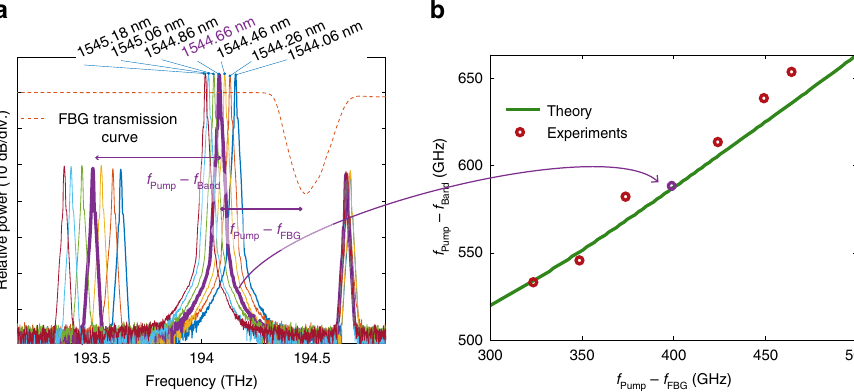
193.5 Fig. 3 Comb tuneability. a Output spectra for different pump wavelengths (from 1544.06 to 1545.18 nm). b Measured repetition rate as a function of the pump to fi bre Bragg grating frequency shift (dots). The violet dot corresponds to the output spectrum depicted in violet in a . The green line represents the frequency which maximises the instability gain calculated from Eq. (5) in